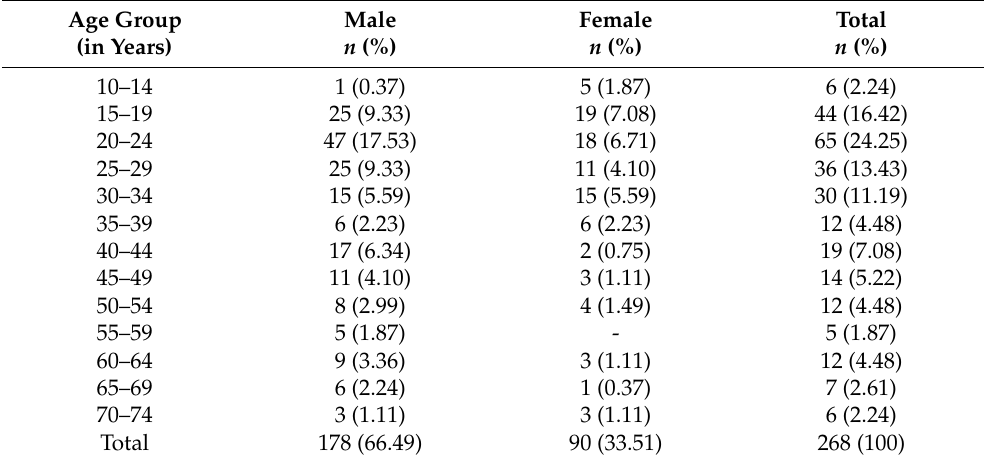
Table 1. Age and gender distribution of drug-resistant pulmonary tuberculosis patients ( n = 268).